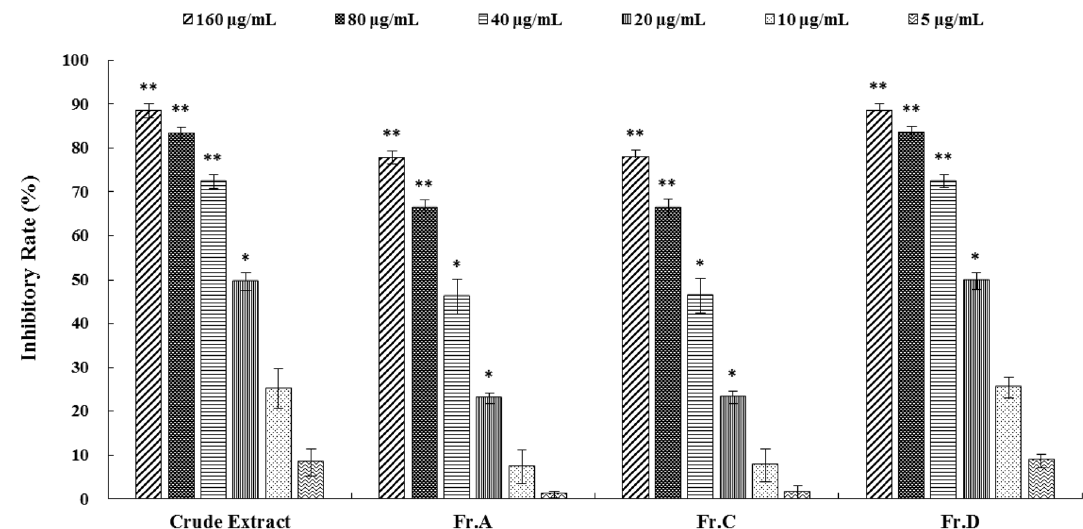
Fig. 3 α-Glucosidase inhibitory activities of crude extract, Fr.A, Fr.C and Fr.D at concentrations of 160, 80, 40, 20, 10 and 5 μg/mL, respectively. Values are presented as inhibitory rate compared to the blank control. Means significantly lower than the controls are indi-